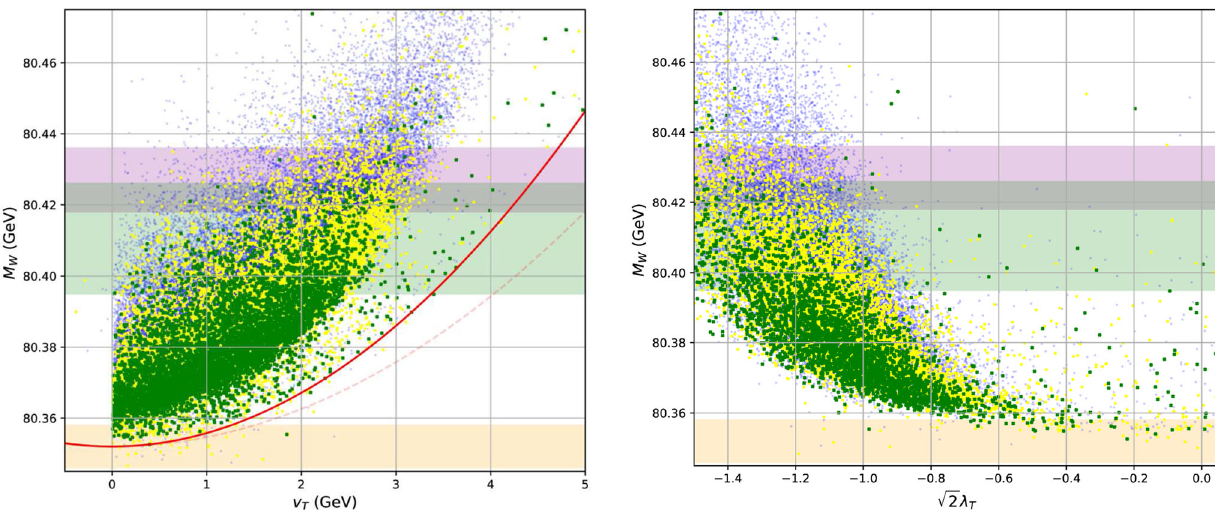
Fig. 5 W boson mass in the general DGNMSSM. Left: W boson mass against triplet expectation value. Right: W boson mass against λ T . Colour coding of points as in previous